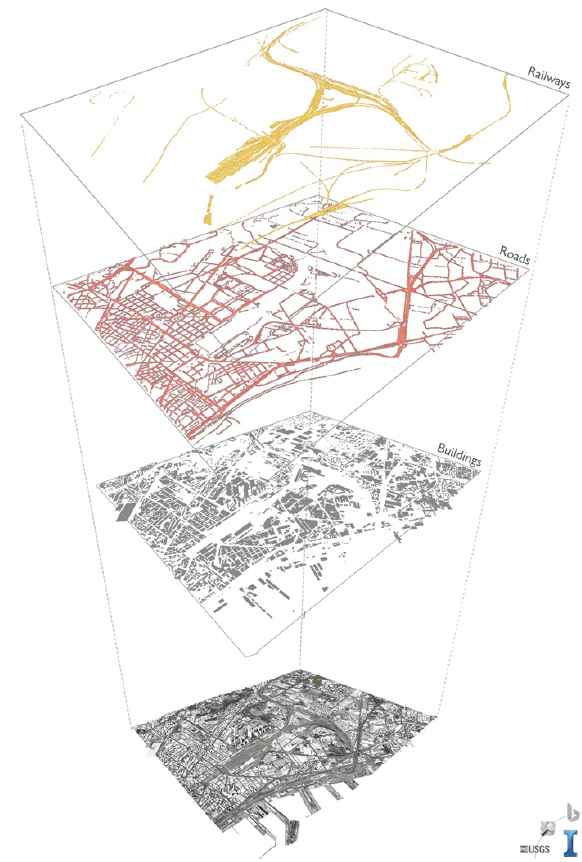
Figure 4 . Preliminary model obtained from the open data as LOD0.